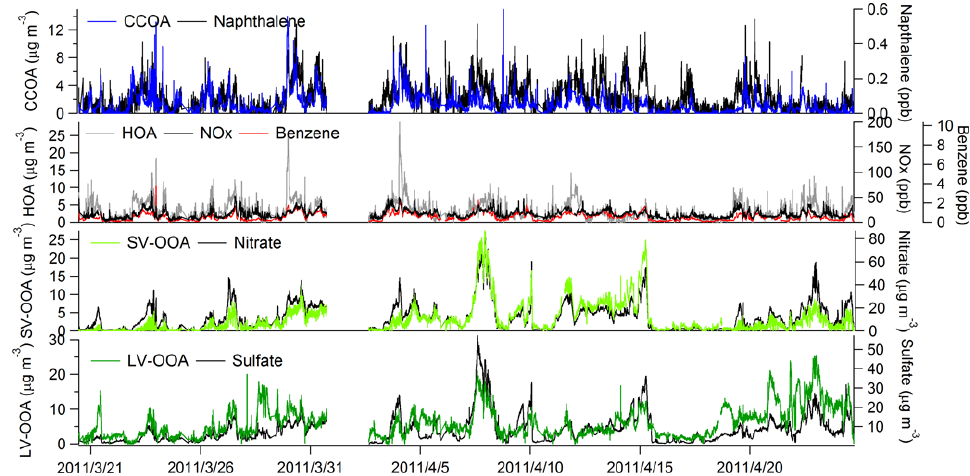
Fig. 5. Time series of OA components and external tracers (naphthalene, NO x , benzene, nitrate and sulfate).